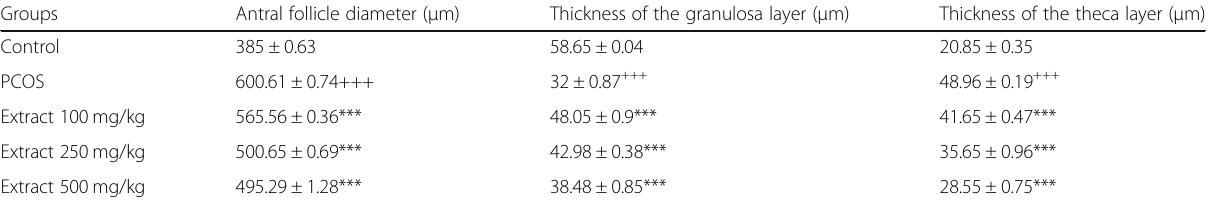
Table 3 Morphometry of antral follicles in different groups (mean ± SEM)